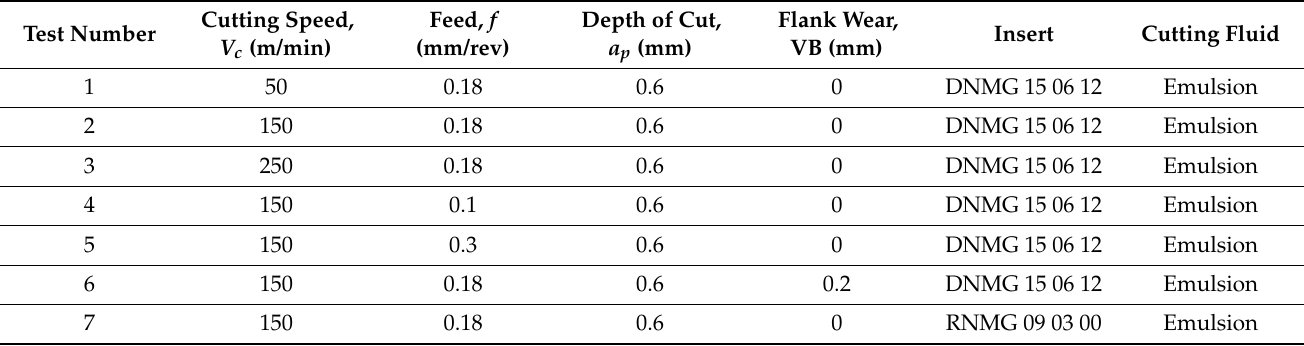
Table 1. Testing conditions.